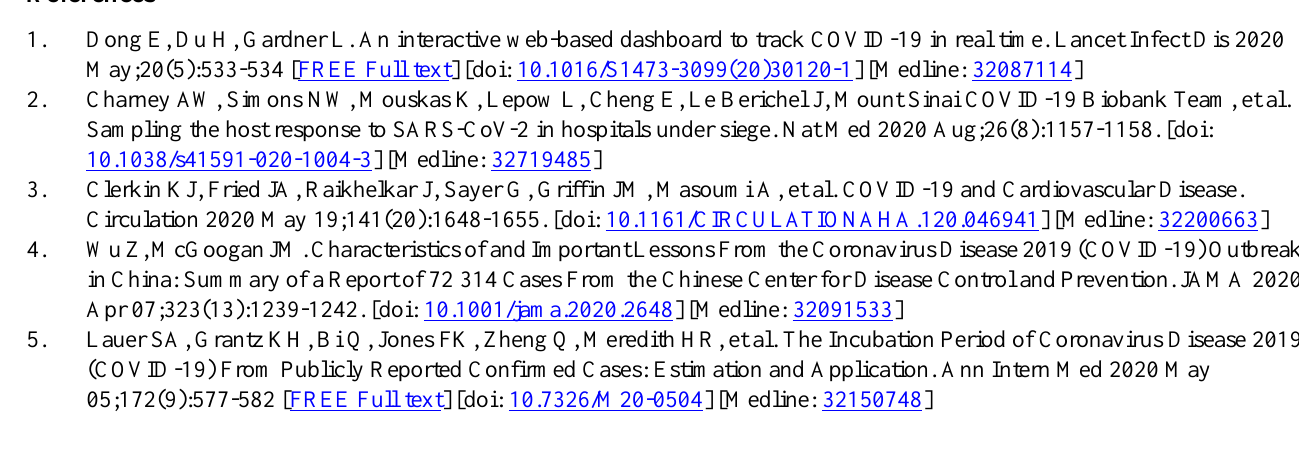
Table S3. Study data as reported using Transparent Reporting of a Multivariable Prediction Model for Individual Prognosis or Diagnosis (TRIPOD)